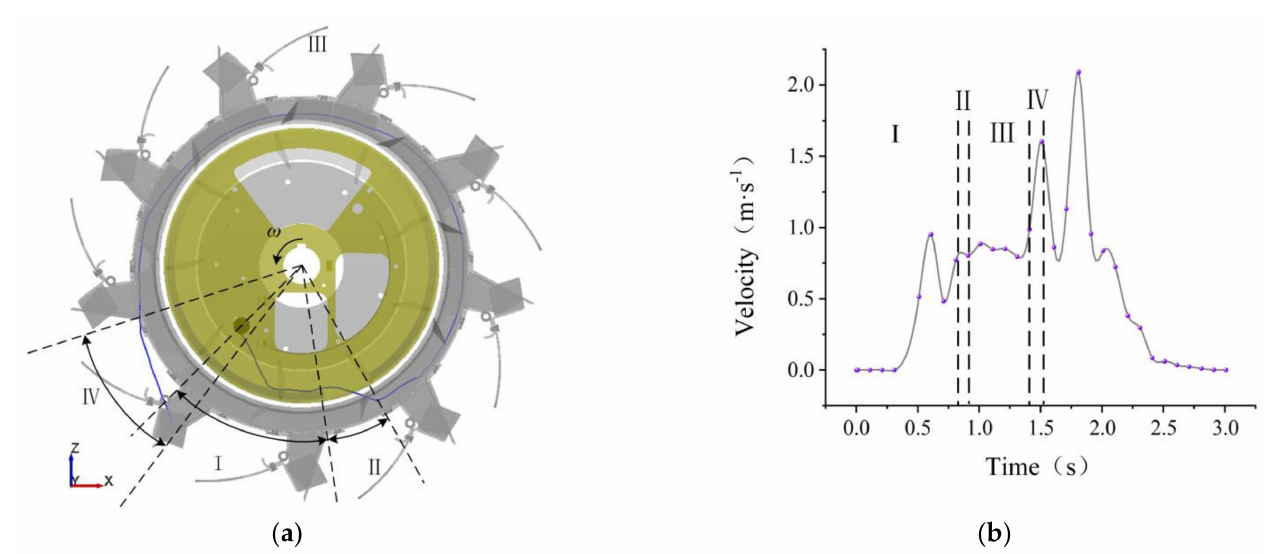
Figure 7. ( a ) Seed-trajectory curve; ( b ) seed-velocity variation